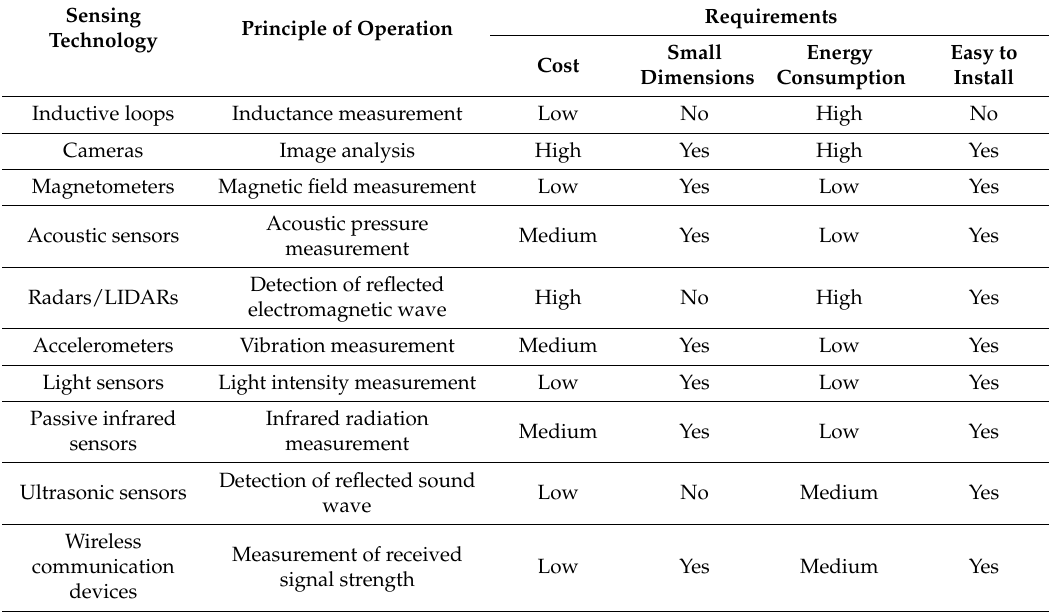
Table 1. Usefulness of sensing